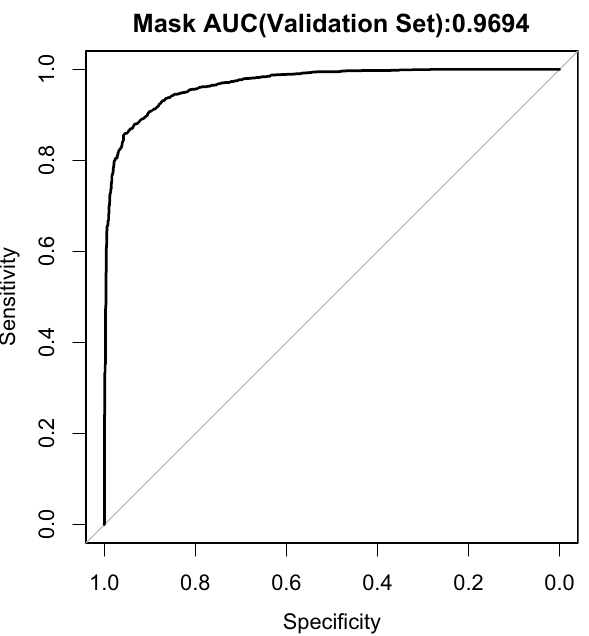
Figure 1. Receiver Operating Characteristics (ROC) curve for mask classifier on the validation set. Sensitivity is the fraction of actual positive data points that the model correctly classifies as positive. Specificity is the fraction of actual negative data points that the model correctly classifies as negative. Higher Area Under the Curve (AUC) values are associated with a greater ability to distinguish positive from negative